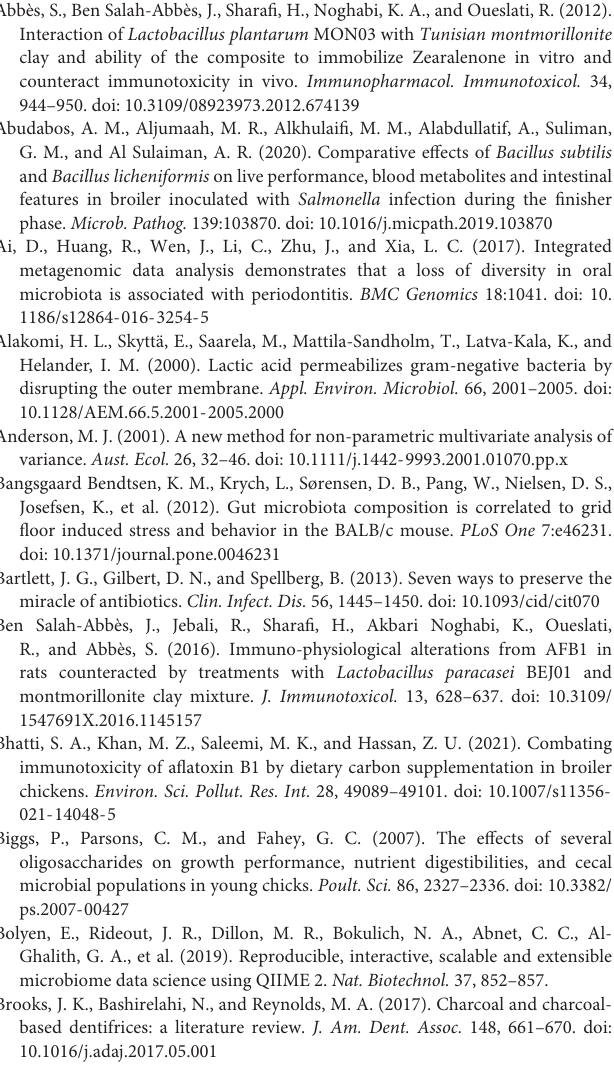
Supplementary Figure 2 | Effects of CHC on α -diversity of cecal and colonic microbiota in broilers on day 42. Bar graphs show changes in indexes of (A) Sobs (upper left panel), Chao 1 (upper right panel), ACE (bottom left panel), and Shannon (bottom right panel) in cecum, (B) Sobs (upper left panel), Chao 1 (upper right panel), ACE (bottom left panel), and Shannon (bottom right panel) in colon. Four indexes analyzed the α diversity of broilers from different directions. NCON is a corn-soybean meal basal diets group. AMP is 200 mg/kg antibacterial peptide supplemented group. Probio is 200 mg/kg calsporin supplemented group. MMT is 500 mg/kg montmorillonite supplemented group. CHC is 500 mg/kg activated charcoal-herb extractum complex supplemented group. Supplementary Figure 3 | Effects of dietary treatment on intestinal microbiota composition at the genus level in the cecum and colon. (A) Cecal bacterial community heatmap in broilers. (B) Colonic bacterial community heatmap in broilers. NCON is a corn-soybean meal basal diets group. AMP is 200 mg/kg antibacterial peptide supplemented group. Probio is 200 mg/kg calsporin supplemented group. MMT is 500 mg/kg montmorillonite supplemented group. CHC is 500 mg/kg activated charcoal-herb extractum complex supplemented